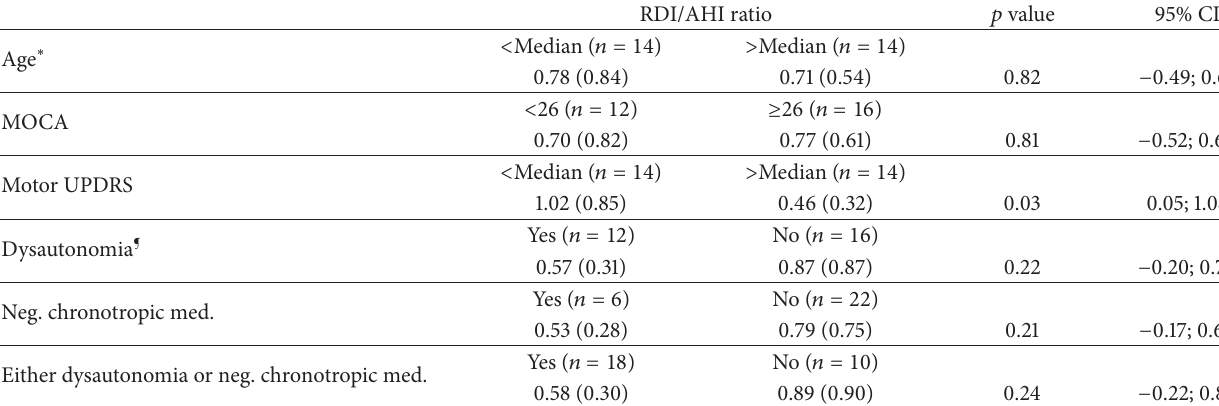
Table 6: Assessment of patient characteristics in relation to discrepancies between RDI and